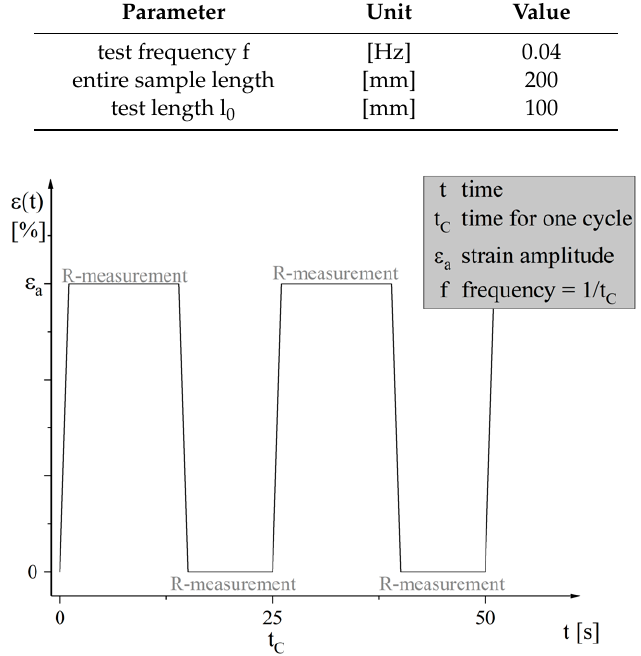
Figure 6. Time-progress of the strain-controlled cyclic tests.